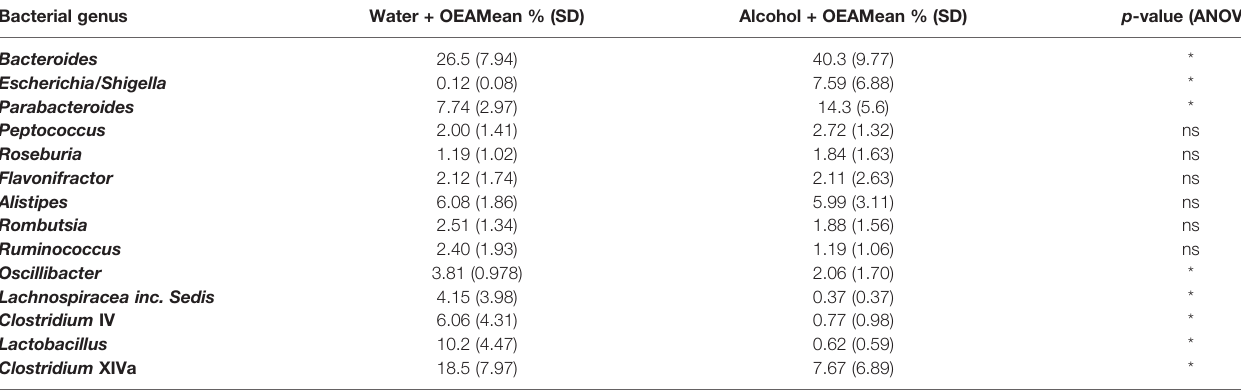
One-way ANOVA: *p < 0.05. ns >